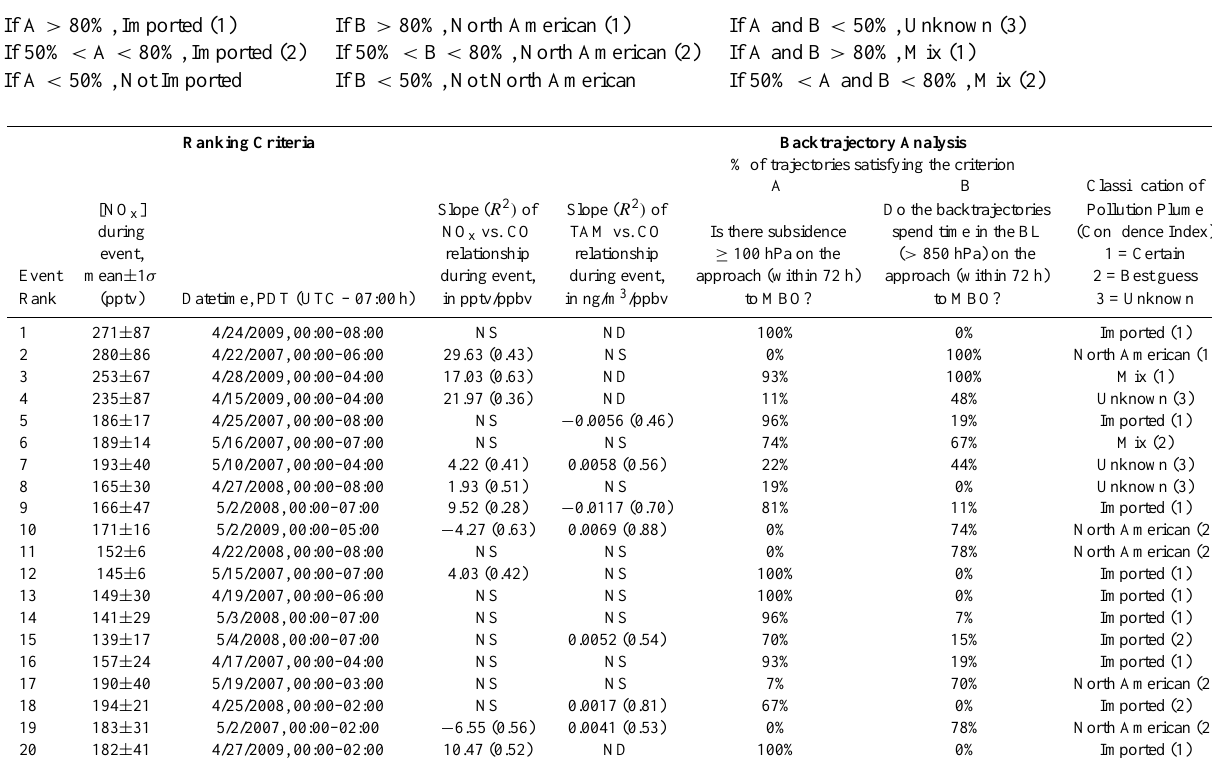
Table 6. Classification using HYSPLIT air mass backtrajectories (using GDAS, NCEP and EDAS meteorological fields) and trace gas ratios from MBO for the top 20 clear-sky, FT NO x events observed at MBO during spring 2007–2009. NS indicates no significant correlation exists (i.e., p-value was > 0.05) and ND indicates no Hg data was available. Numbers in parentheses below indicate “Confidence